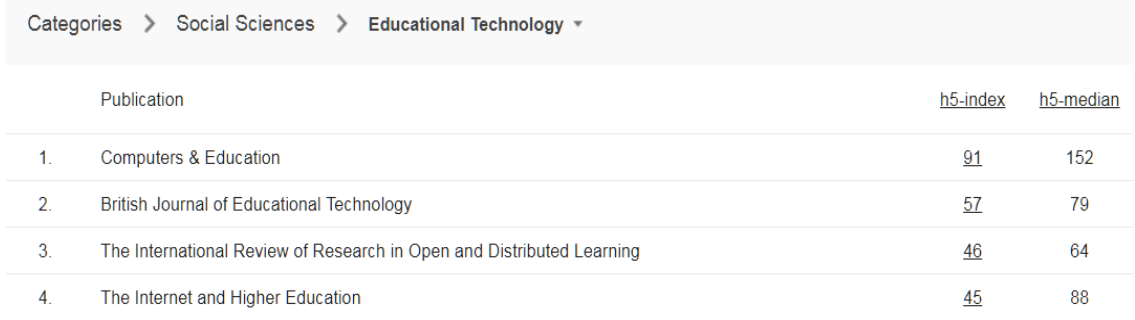
Figure 1. The top four educational technology research journals in 2019.